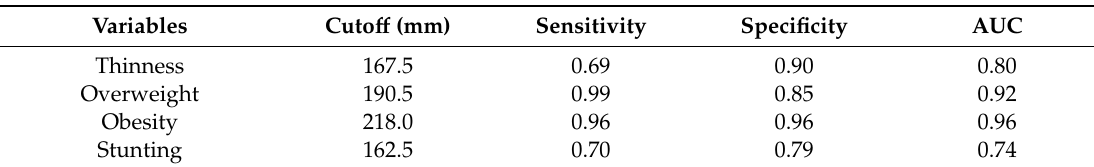
Table 2. Optimal MUAC cutoff values, with stratification by age group and birth weight, in schoolchildren aged 5–10 years ( n =